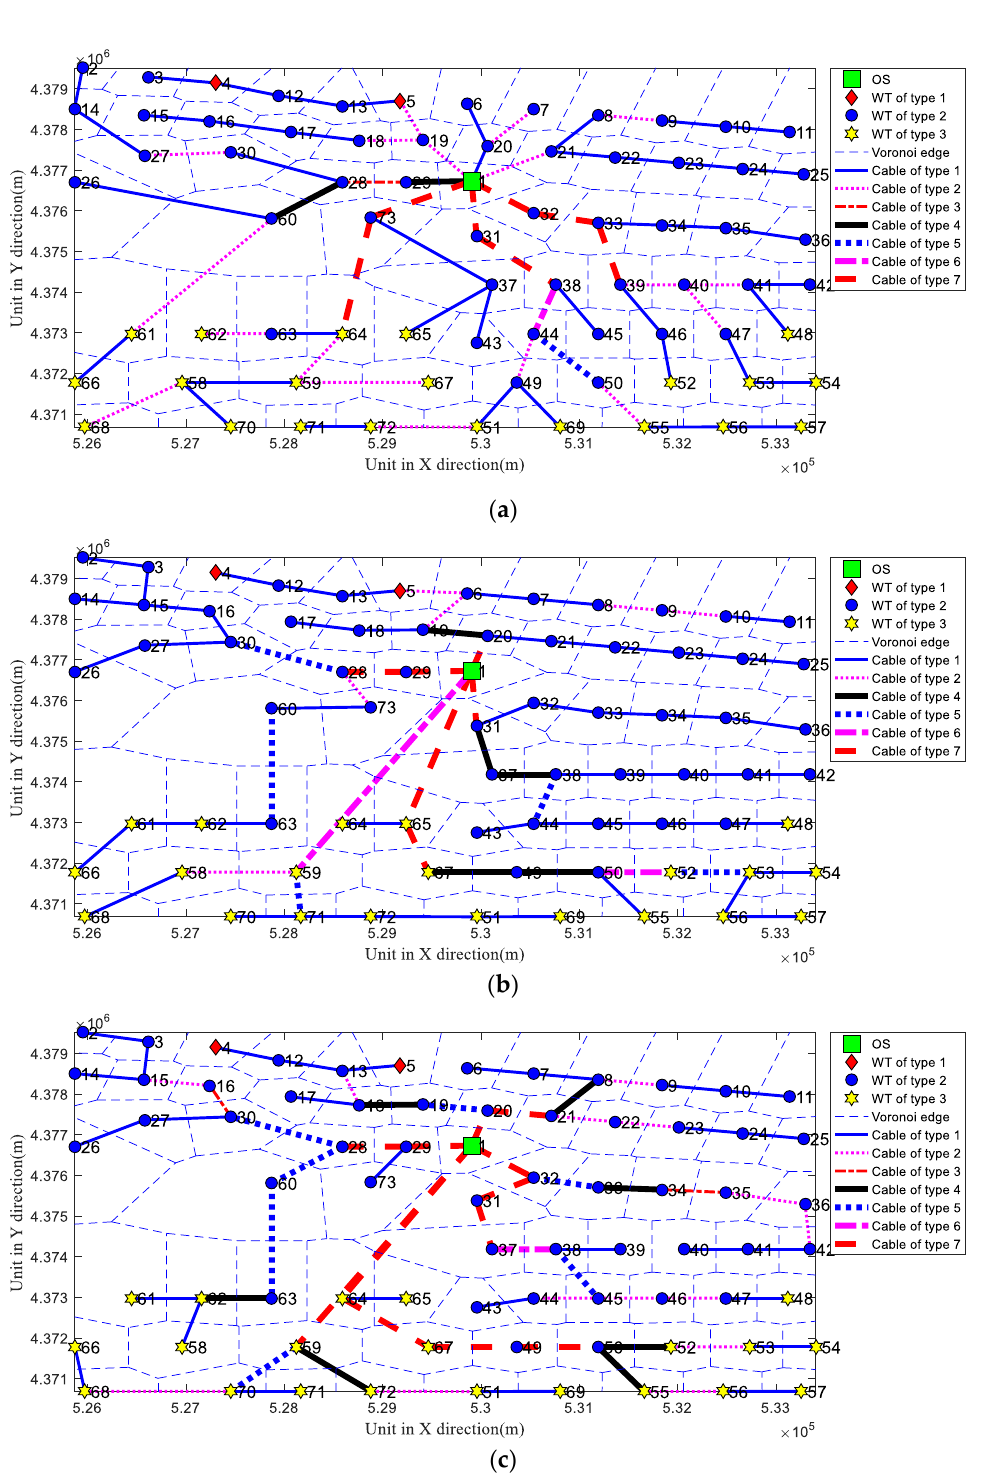
Figure 13. Optimized cable connection scheme. ( a ) Optimized layout obtained by V-APSO; ( b ) Optimized layout obtained by APSO-MST; ( c ) Optimized layout obtained by V-WGA-LS.